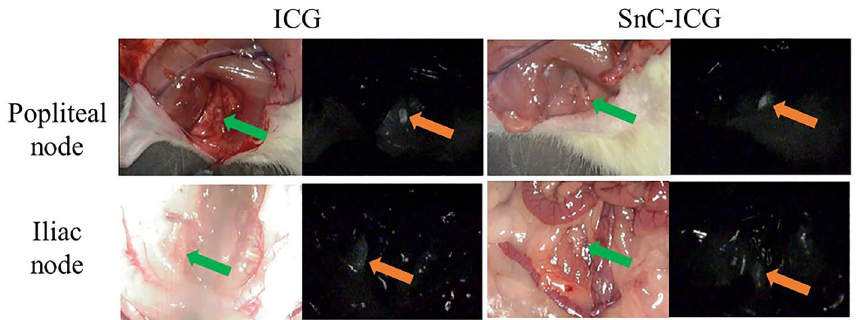
Figure 1. Appearance of regional lymph nodes (LNs) after the administration of indocyanine green aqueous solution (ICG) or a stannous colloid/ICG mixed tracer (SnC–ICG) under bright-field (left) and near-infrared (NIR) fluorescence (right) cameras. The arrows indicate the regional LN. Fluorescent nodes are rather ambiguous in this figure because these images were extracted from movies captured by NIR fluorescence